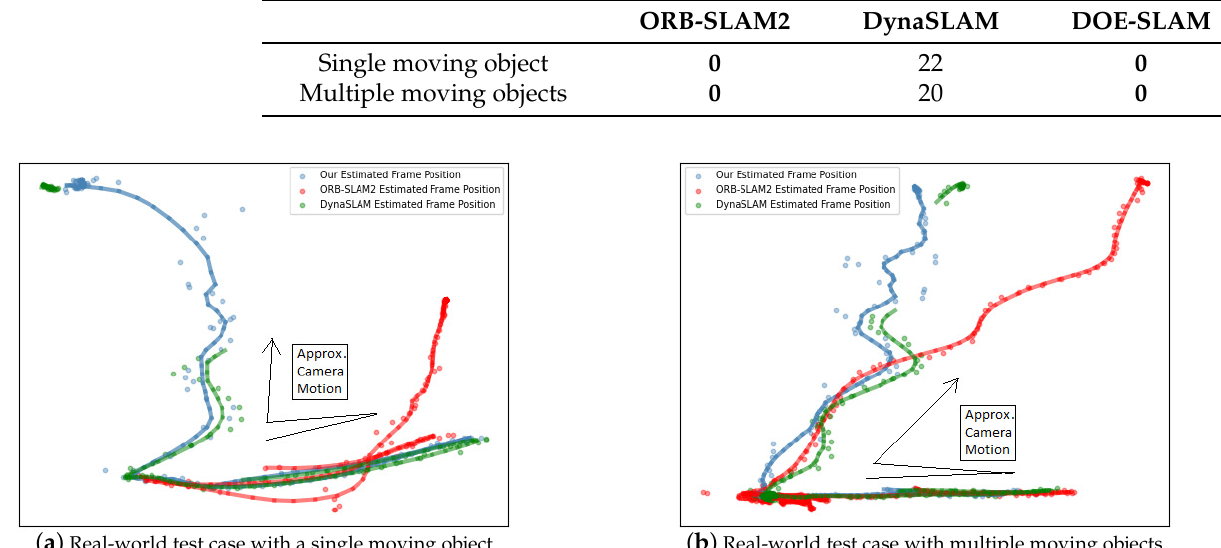
Figure 7. The estimated position of frames in real-world test cases by ORB-SLAM2, DynaSLAM, and DOE-SLAM. In both scenarios, the exact ground truth trajectory was unknown, but the general motion was from left to right and back to the left, followed by a forward